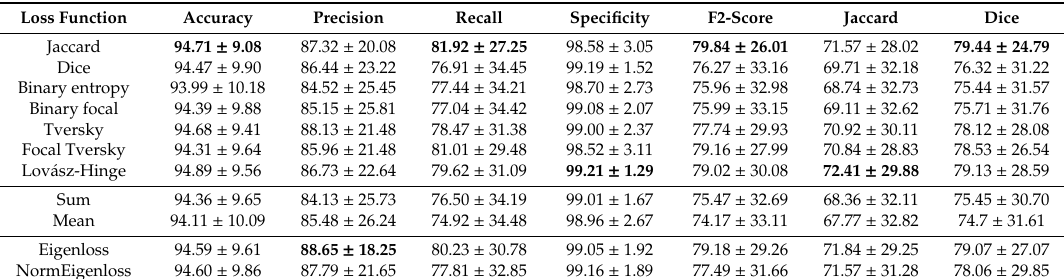
Table 4. LinkNet-Densenet121. Results of the model trained with the di ff erent loss functions, reported over the test set of CVC-EndoSceneStill. Best values are indicated in